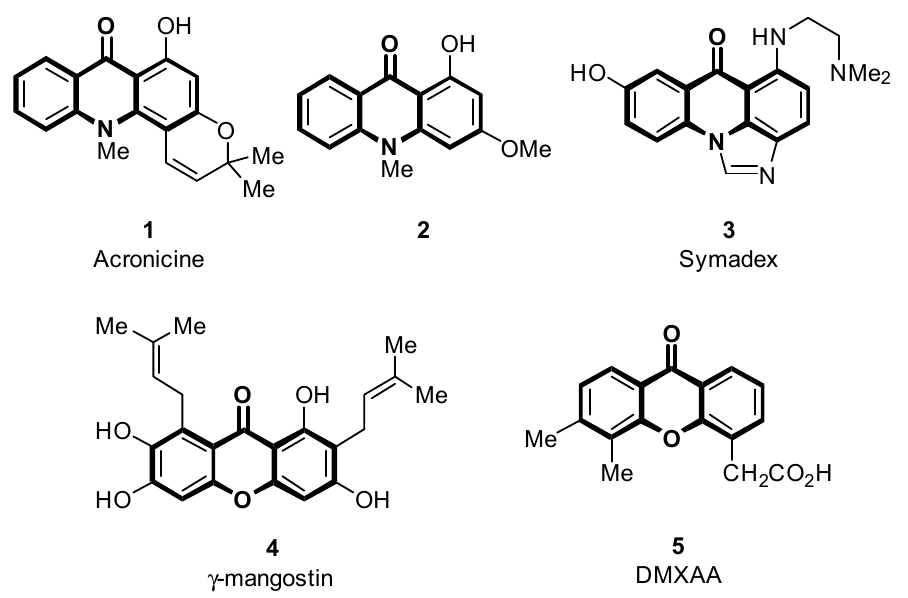
Figure 1. Some important acridone and xanthone derivatives.